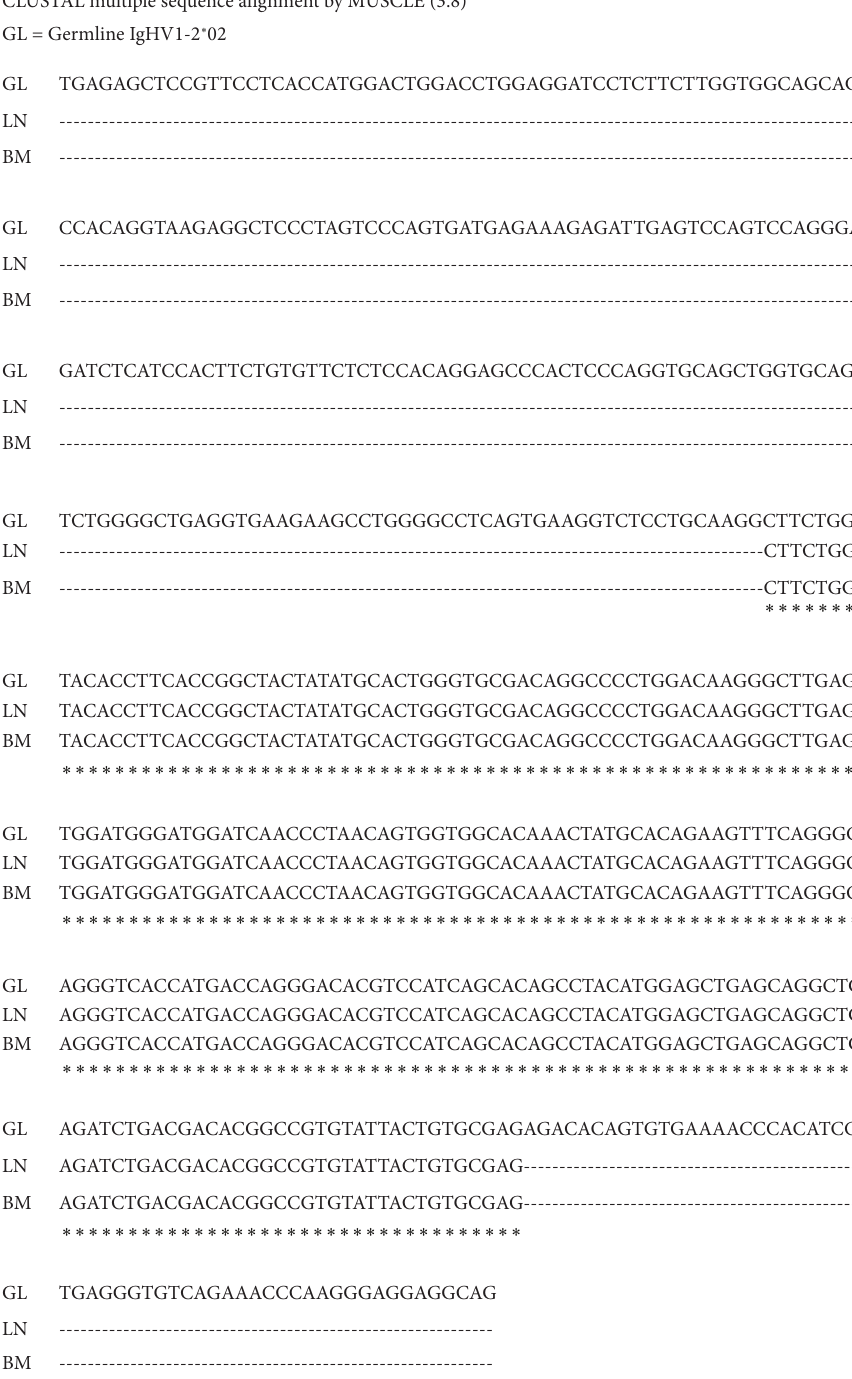
Figure 3: Alignment of the clonal VDJ sequence to germline V1-2 ∗ 02 The clonal sequence (FR1-J) from the lymph node and bone marrow shows an unmutated V region when aligned to the germline V gene. GL: germline sequence, LN: lymph node, and BM: bone